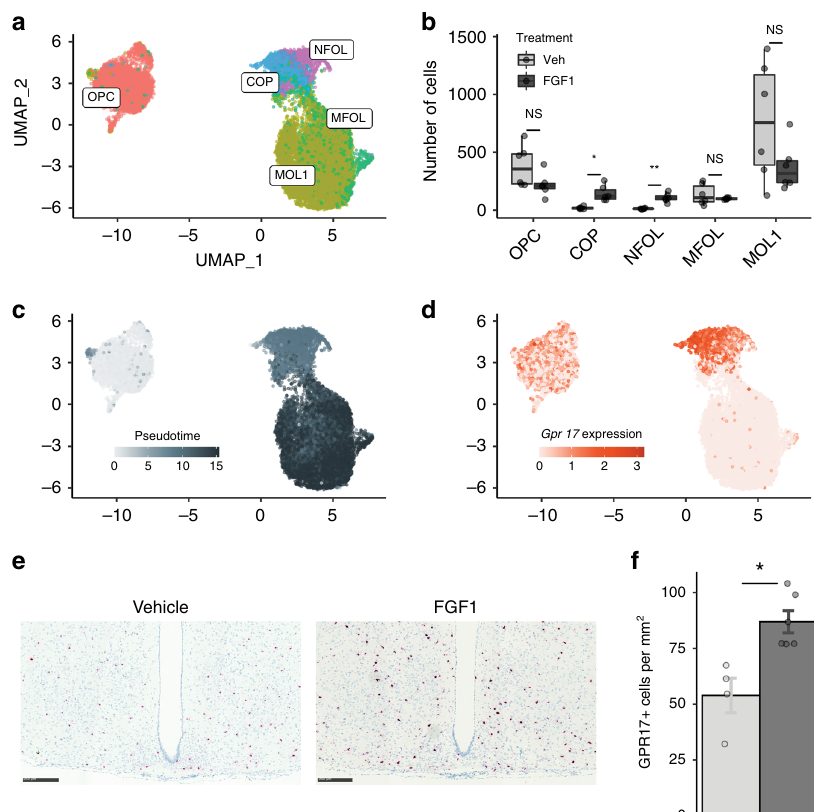
Fig. 4 Icv FGF1 induces a population of differentiating oligodendrocytes. a UMAP clustering of cells in the oligodendrocyte lineage from the Day 5 scRNA-seq dataset. Cell type annotations were inferred from a published dataset 35 . b Dots represent mean number of cells per animal and lines represent mean ± SEM. Unpaired t test, two tailed, * p < 0.022, ** p < 0.0074 (Bonferroni adjusted; n = 6 mice/group); ns not signi fi cant. Source data for each subcluster are provided as a Source data fi le. c UMAP of cells in the oligodendrocyte lineage labeled according to maturation in Monocle-derived pseudotime. d UMAP of cells expressing Gpr17 , a maturing oligodendrocyte marker. e RNAScope detection of Gpr17 expression in the hypothalamus of Lep ob/ob mice 5 days after icv FGF1 or vehicle. f Quanti fi cation of Gpr17 + cells from the ARC area (2 sections per animal, icv vehicle ( n = 4) and icv FGF1 ( n = 5)), mean ± SEM. Unpaired t test, two tailed, * p = 0.005 (not adjusted). Source data are provided as a Source data fi le. NFOL newly